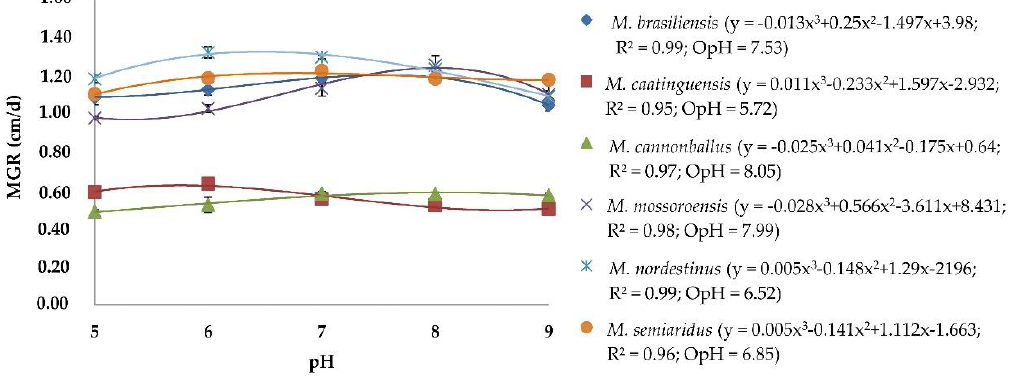
Figure 1. Regression equation, coefficient of determination (R 2 ) and optimal pH for mycelial growth (O pH ) of Monosporascus spp. isolates. y = adjusted with the values of the mycelial growth rate (MGR) at pHs 5, 6, 7, 8, and 9. O pH = optimal hydrogen ion potential for mycelial growth of Monosporascus spp. calculated from the regression equation.